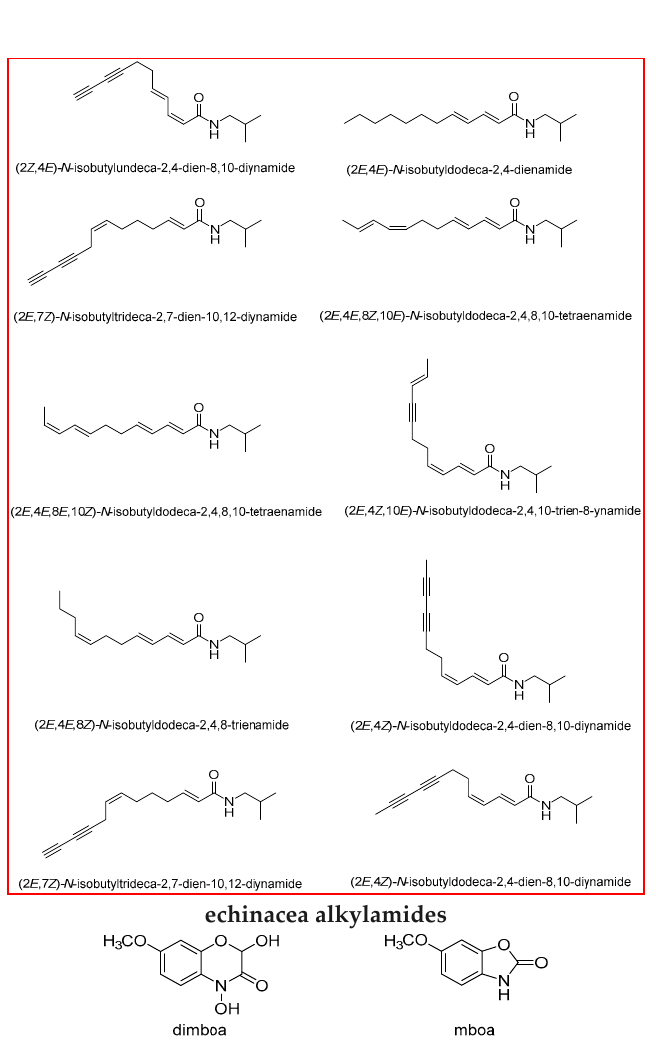
Figure 2. Chemical structures of reported natural safeners (sanshools, echinacea alkylamides, Z- ligustilide, senkyunolide A, bergapten, isopimpinellin, salicylic acid, gibberellin A 3 , brassinolide, methyl jasmonate, methyl dihydrojasmonate, melatonin, dimboa, and mboa). Table 1. Names, applied crop plants, application modes, first discovery time of natural